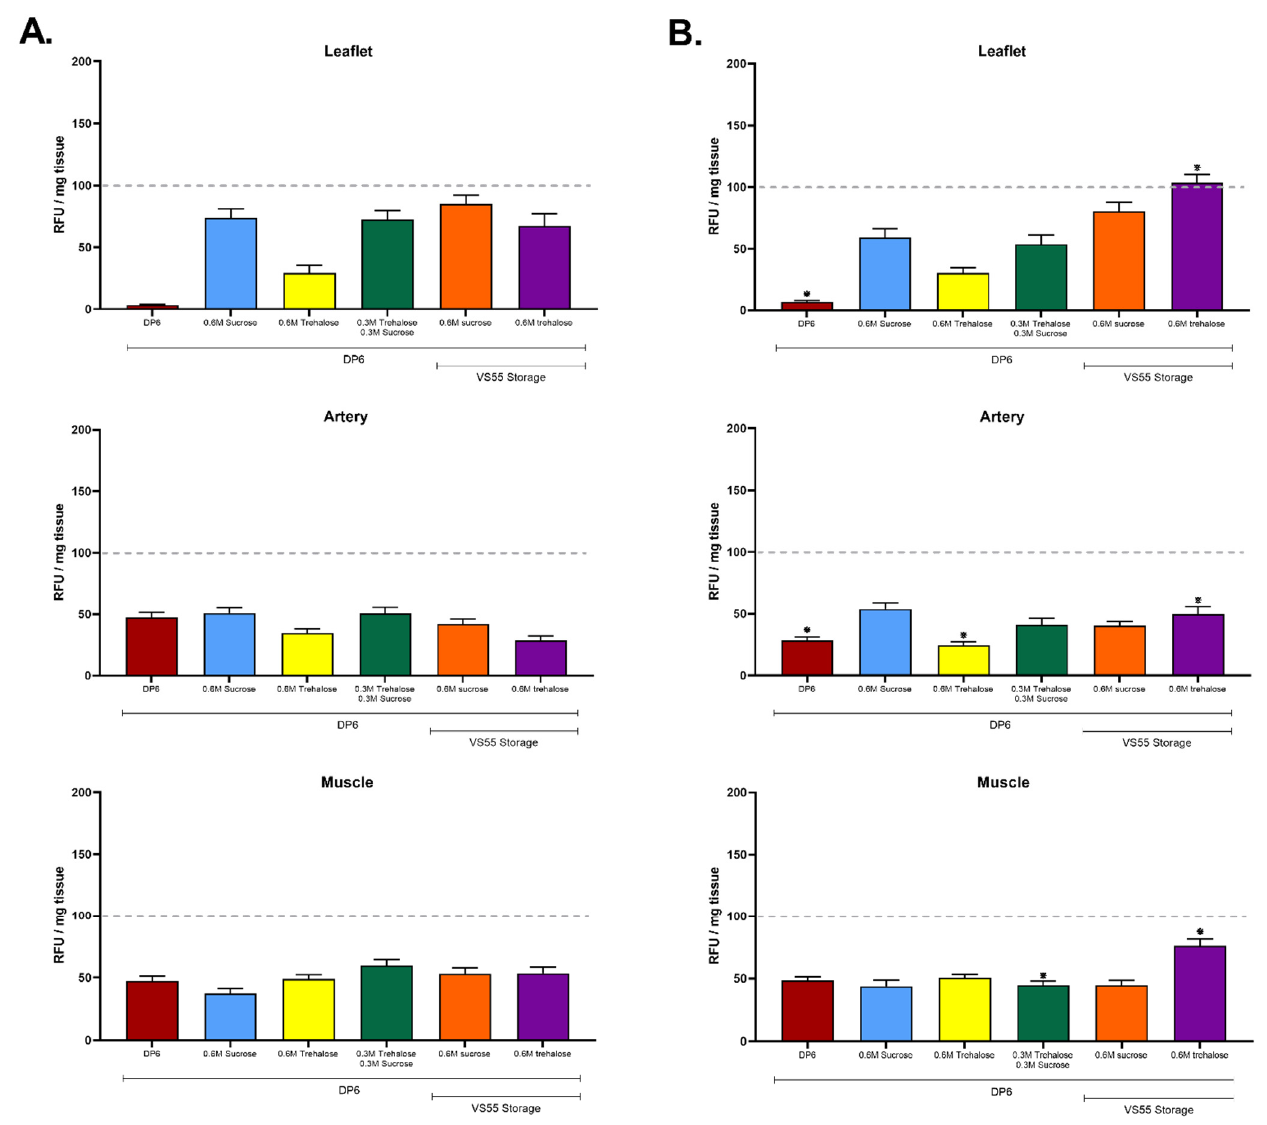
Figure 2. Ice-free vitrification of pulmonary heart valves comparing impact of loading with DP6 on viability after vitrification in DP6 + disaccharides or VS55 + disaccharides. ( A ) No Fe, with boundary warming. ( B ) Nanowarmed with Fe. The top graph in each case is leaflets, center is pulmonary artery, and the bottom is fibrous muscle band at the base of the heart valve. Viability was assessed using alamarBlue. The best outcomes were observed with VS55 + 0.6 M trehalose and nanowarming for each tissue type. The results are shown as the mean ± 1 standard error, p < 0.05. * comparison of ± Fe.